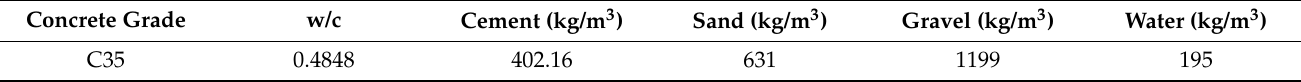
Table 2. Mixture proportion of concrete in the present study.